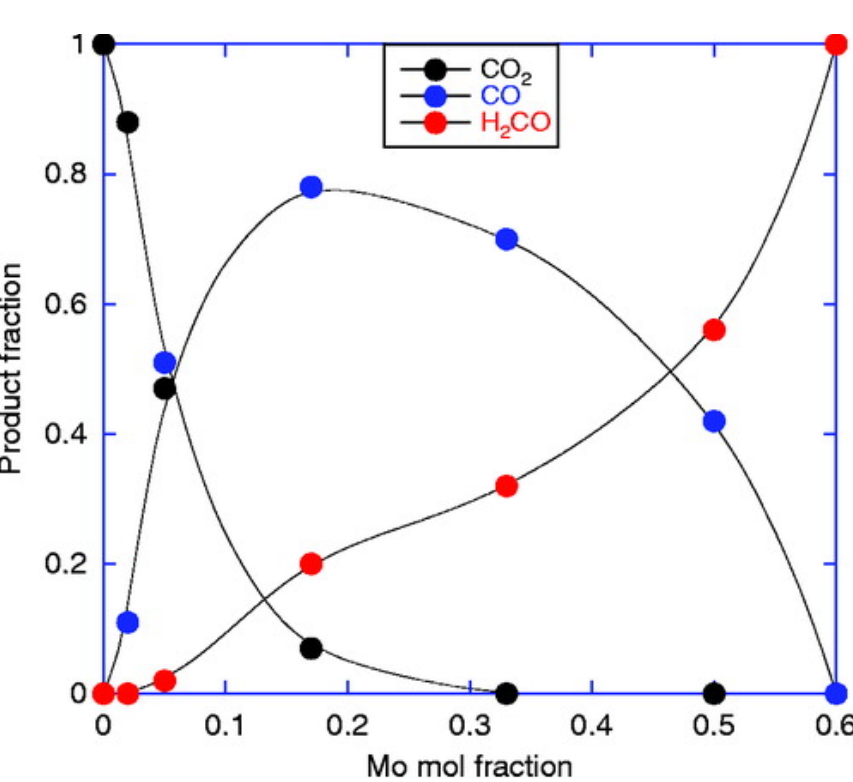
Figure 5. The product’s dependence yields on Mo’s mass loading. Reprint from [107]. Copyright (2021), with permission from Taylor & Francis Online.